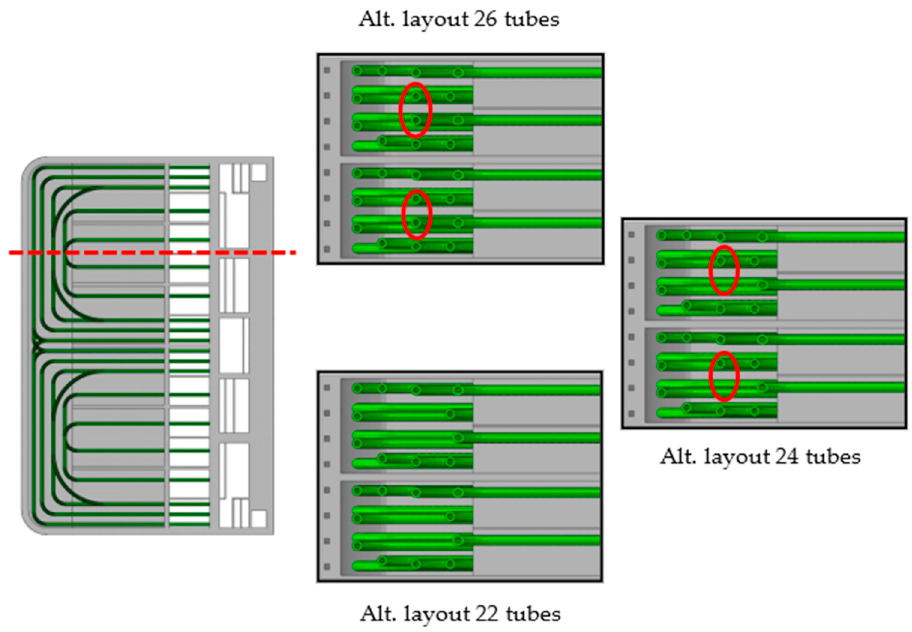
Figure 8. Alternative DWTs layout equipped with 26, 24, and 22 tubes.